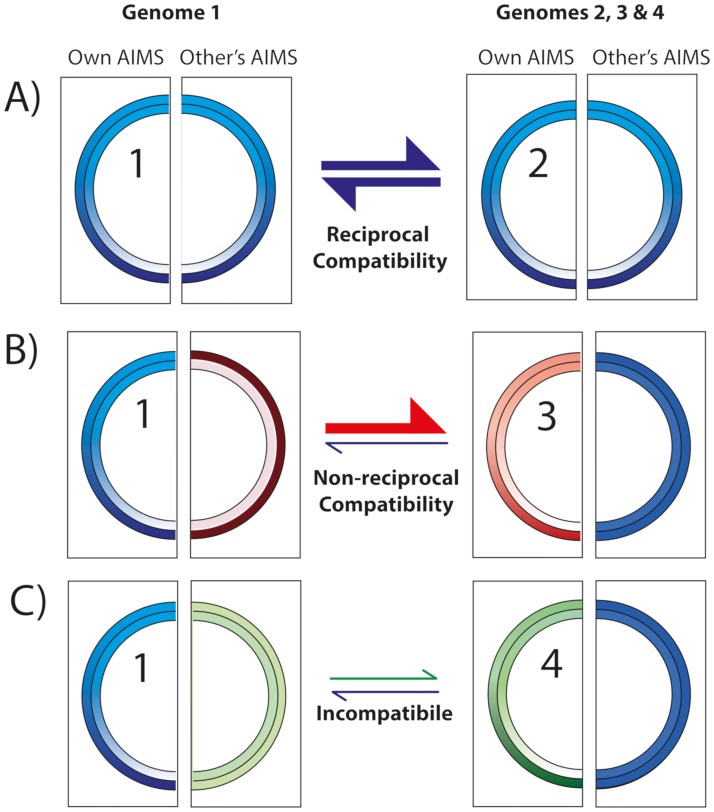
A model for the compatibility of genomes for gene transfer as a function of AIMS.AIMS in different compatibility groups are shown in different colors; darker colors indicate more abundant sequences. Genomes are numbers 1 through 4; colored bands indicate the abundance of oligomers that are AIMS within that genome (own AIMS) or AIMS within the partner genome (other’s AIMS). A. Genomes 1 and 2 share AIMS (blue); therefore, AIMS would not reduce gene transfer between these genomes. B. Gene transfer from genome 3 to genome 1 is reduced because sequences which serve as AIMS in genome 1 (blue) are not strand-biased in genome 3. However, gene transfer from genome 1 to genome 3 is not reduced because sequences serving as AIMS in genome 3 are strand-biased in genome 1 (red). C. AIMS reduces transfer between genomes 1 and 4 in both directions as sequences serving as AIMS in one genome (blue in genome 1, green in genome 4) are not strand-biased in the other genome.